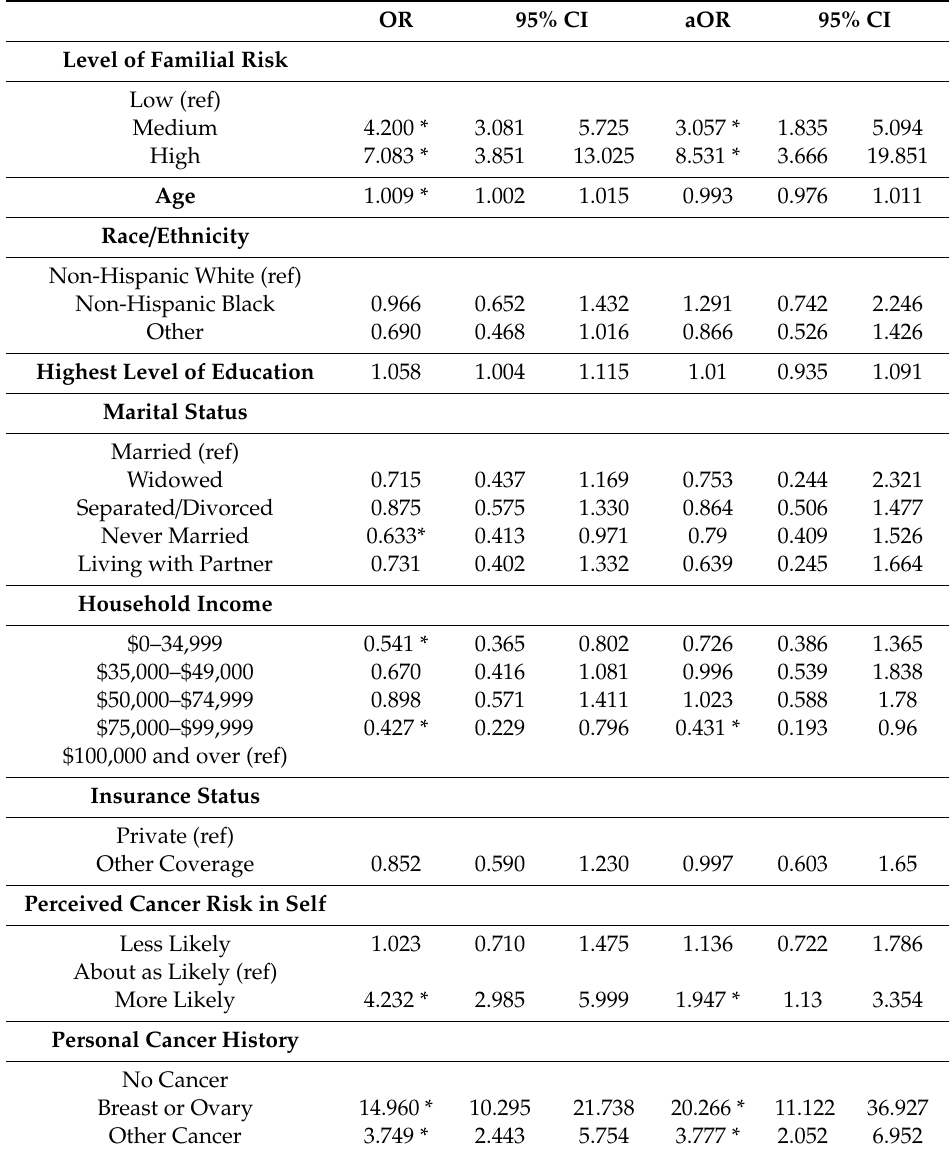
Table 4. Associations with Genetic Testing for Cancer